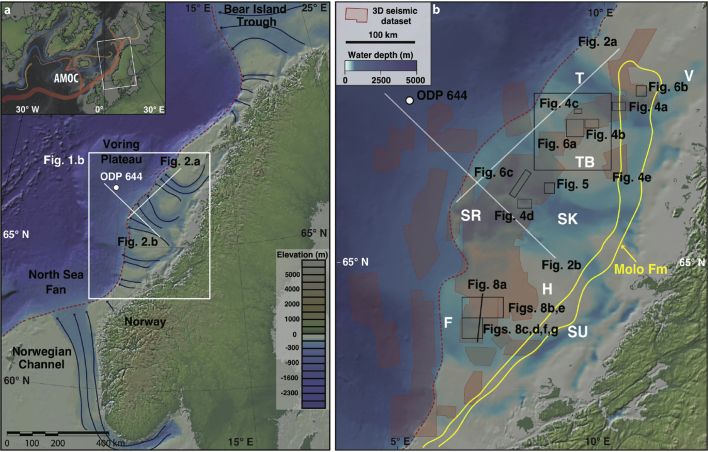
The mid-Norwegian continental margin. a. Dark blue lines show locations of multiple fast-flowing ice streams that drained the western margin of the Fennoscandian Ice Sheet during the Last Glacial Maximum (from Ottesen et al., 2005). Red dashed lines show the modern shelf break. Inset: large-scale ocean-surface circulation in the North Atlantic. AMOC – Atlantic Meridional Overturning Circulation. b. Study area (the mid-Norwegian continental margin between 64 and 68°N) 3D seismic data coverage of the study area (transparent red areas) and 2D seismic lines GMNR94-106 and GMNR94-302. Yellow line indicates the subcrop of the fluvial Molo Formation. T-Traenadjupet, TB-Traenabanken, SK-Sklinnadjupet, SR-Skjoldryggen, H-Haltenbanken, SU-Suladjupet, F-Frøybankhola, V-Vestfjorden. (For interpretation of the references to colour in this figure legend, the reader is referred to the web version of this article.)